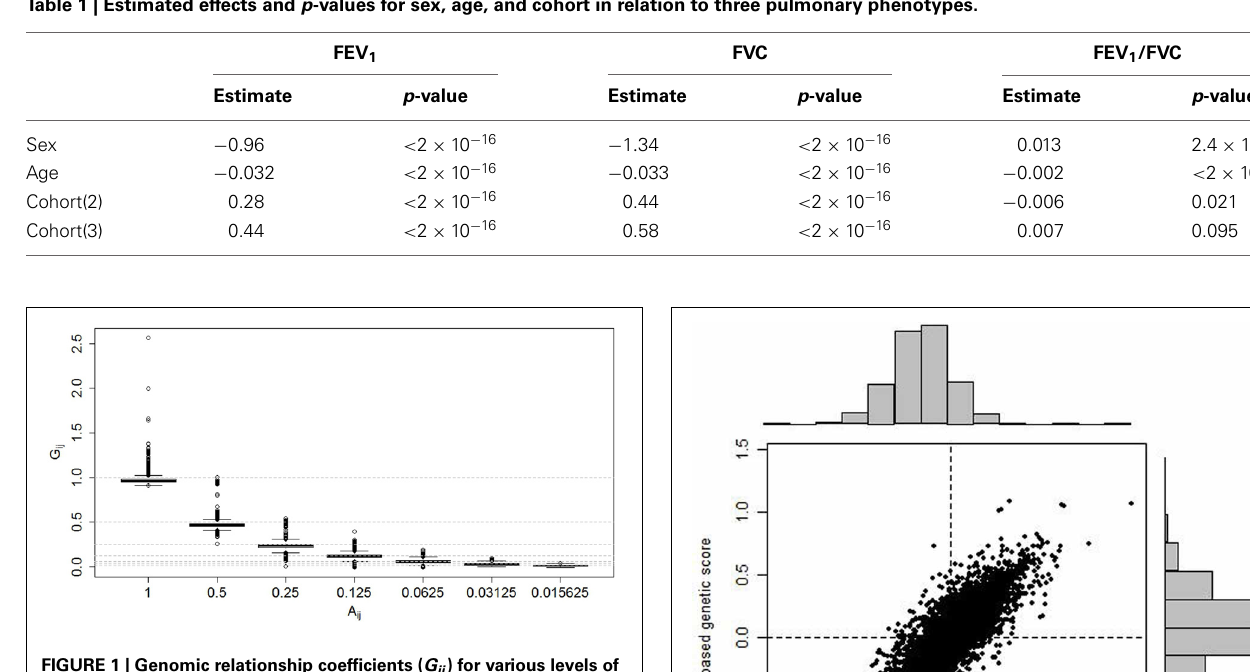
FIGURE 1 | Genomic relationship coefficients ( G ij ) for various levels of pedigree-based relationship coefficients ( A ij ). Horizontal dashed lines indicate the different levels of expected coefficients on the y-scale.